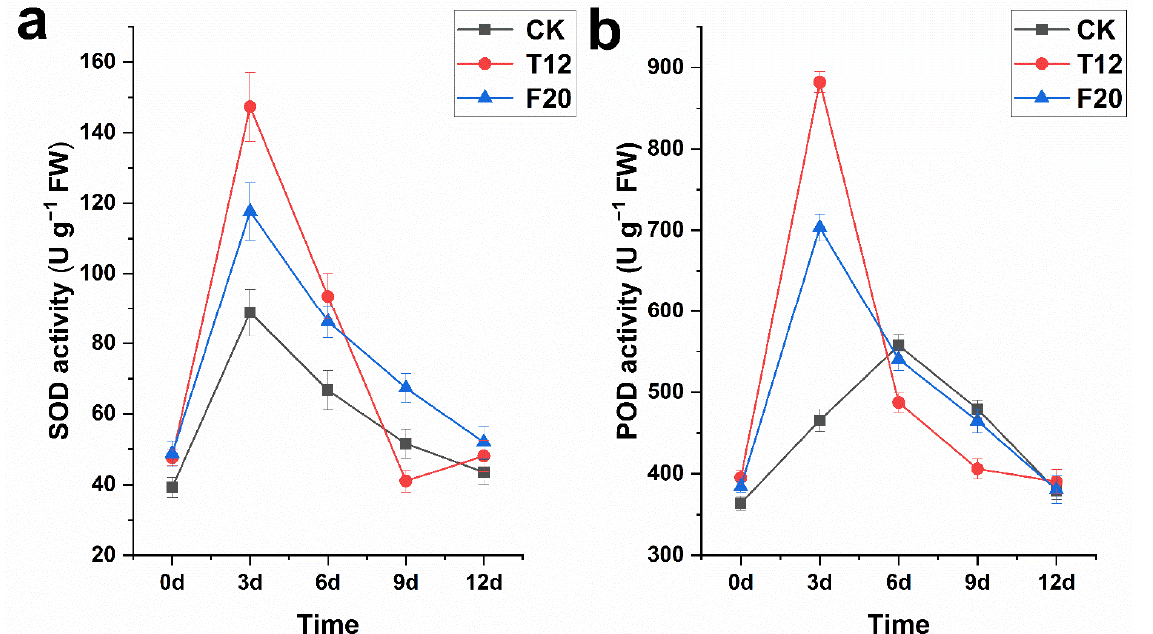
Figure 3. SOD and POD activity of CK, T12, and F20 before and under salt stress.